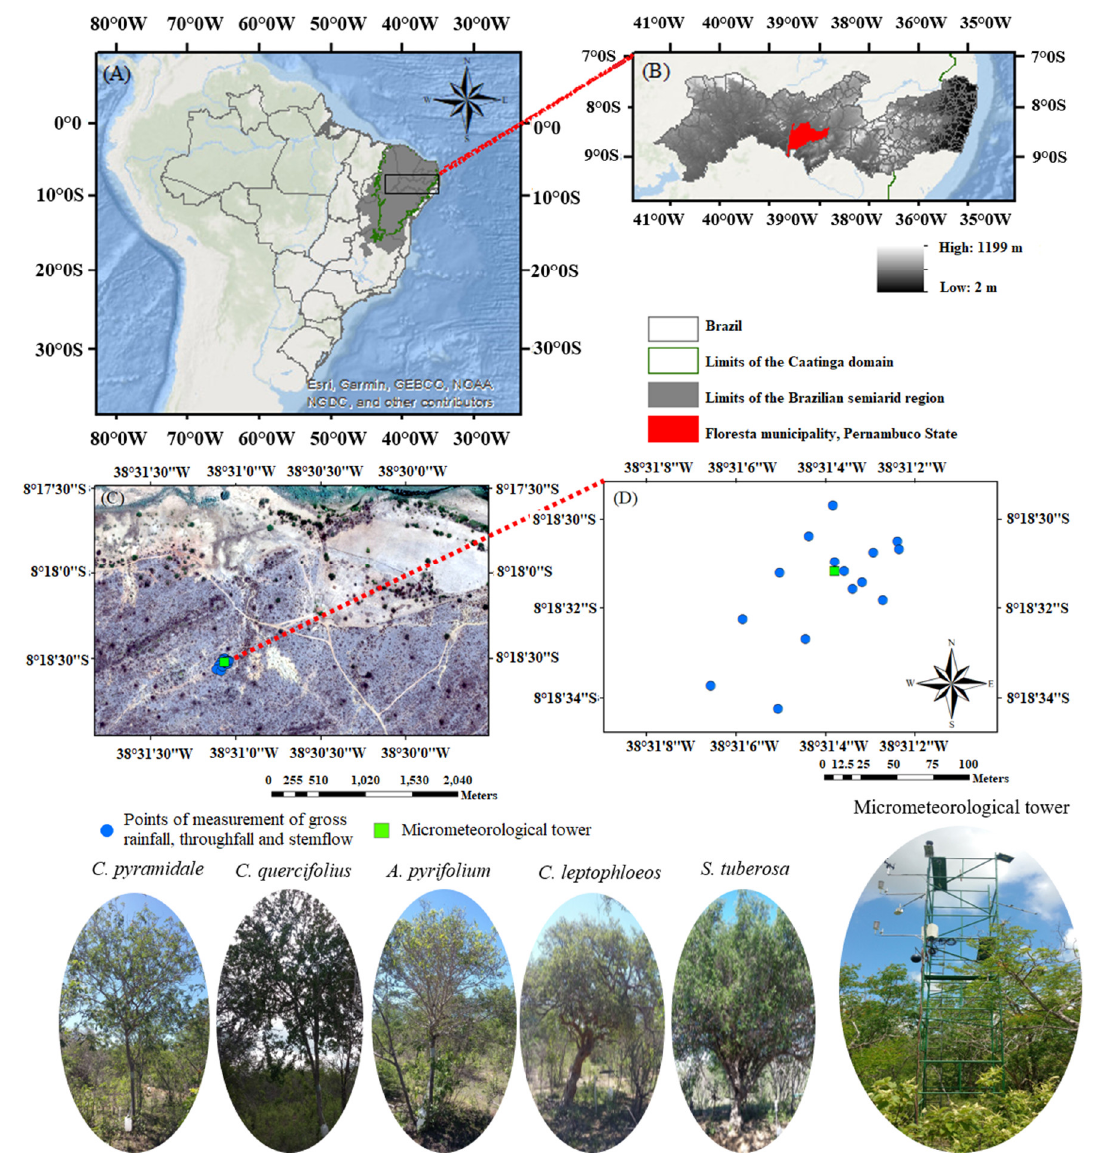
Figure 1. Study area, monitored trees and micrometeorological tower.